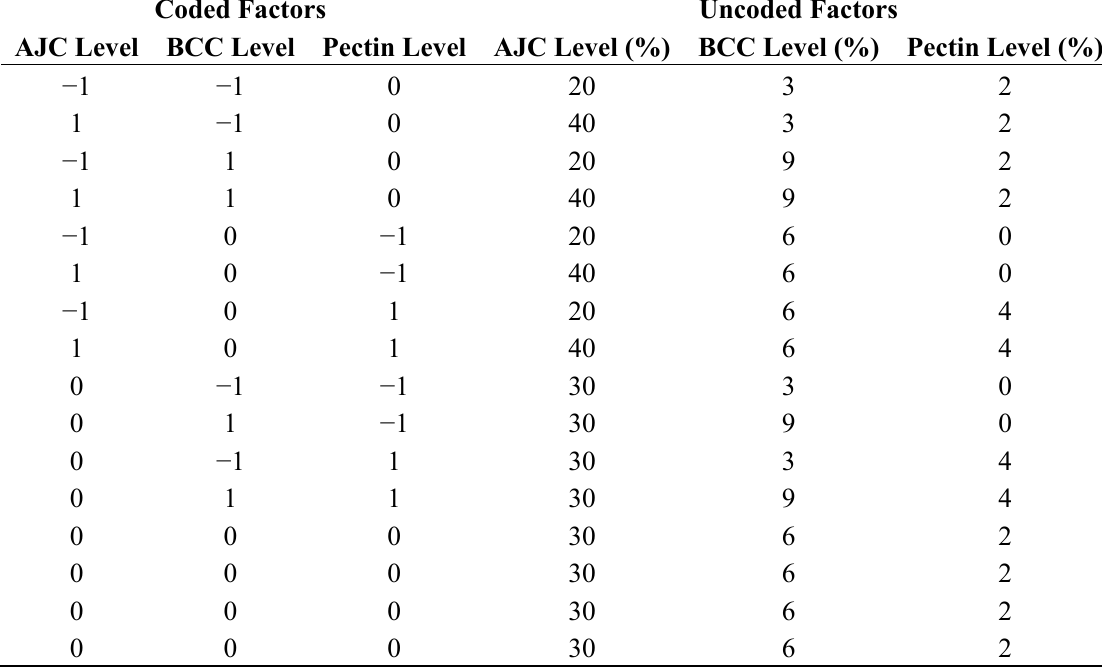
Note: −1, low level; 0, middle level; 1, high